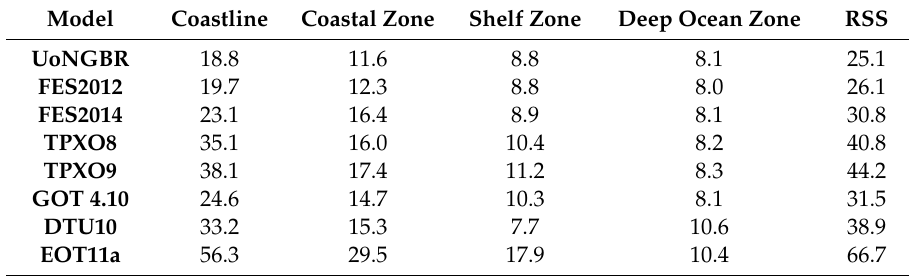
Table 6. The mean RMS (cm) of the SLAs and Root Sum Square (RSS) (cm) in the study area with the bold value indicating the minimum mean RMS (or